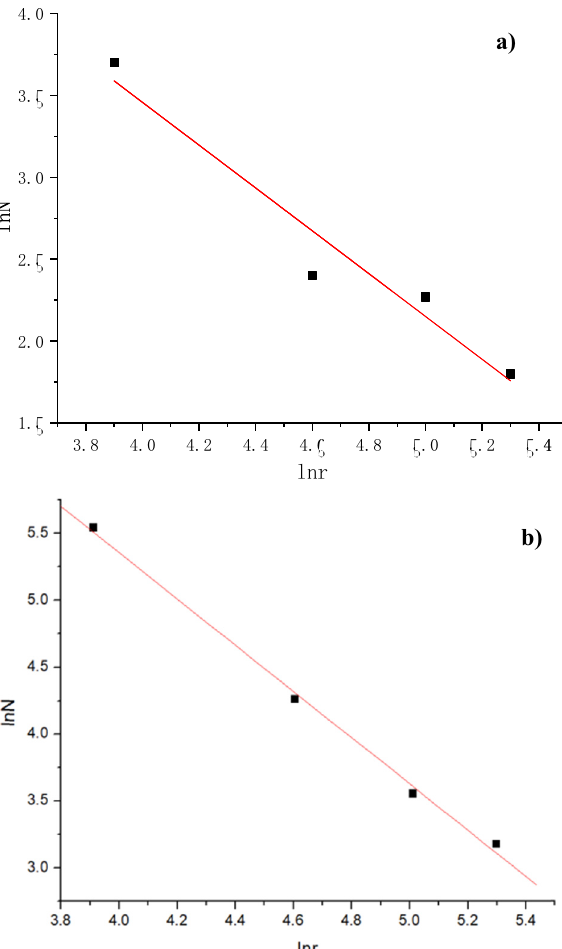
Figure 5: Double logarithmic fi tting of natural sand ( a ) and Type I recycled sand ( b ) . Figure 6: Double logarithmic